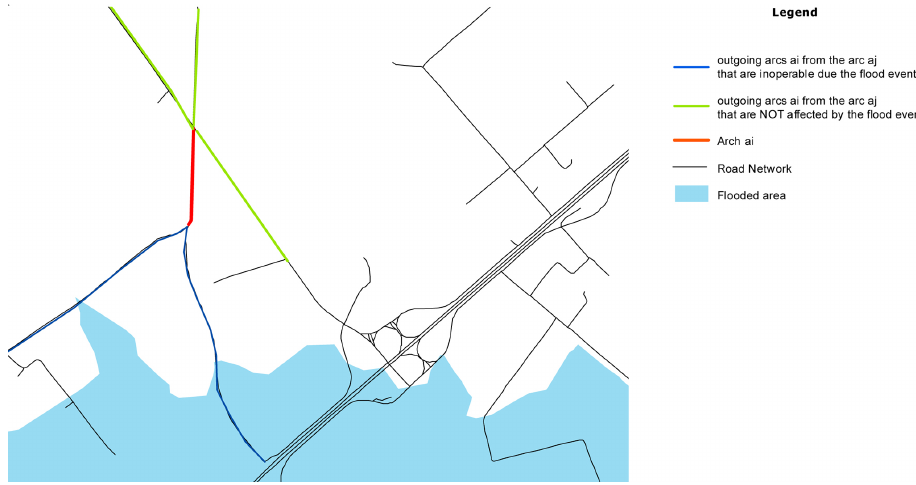
Figure 7. Graphical example of the elements (i.e. arc a i and its outgoing arcs a j ) involved in Eq.